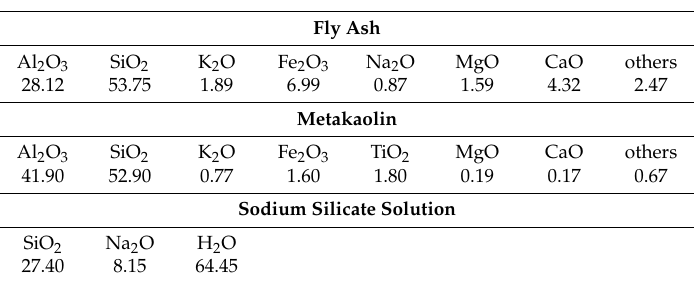
Table 1. Chemical composition (weight%) of weathered fly ash used in this paper after thermal treatment at 950 ˝ C, metakaolin and the sodium silicate solution. Fly Ash Al 2 O 3 SiO 2 K 2 O Fe 2 O 3 Na 2 O MgO CaO others 28.12 53.75 1.89 6.99 0.87 1.59 4.32 2.47 Metakaolin Al 2 O 3 SiO 2 TiO 2 MgO